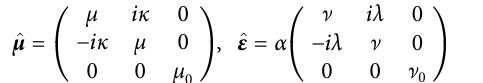
Frontiers in Materials |